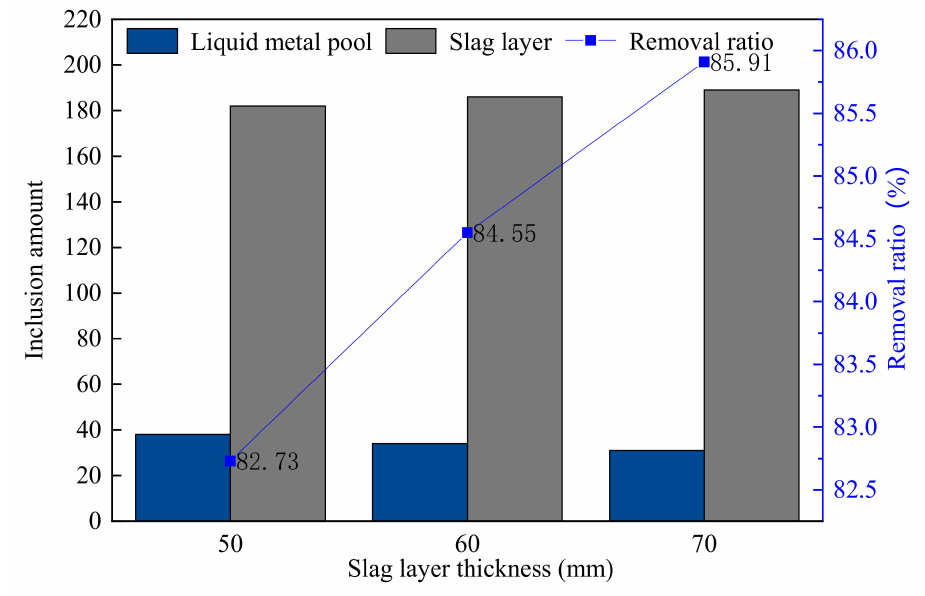
Figure 12. Comparison of removal ratio with different slag-layer